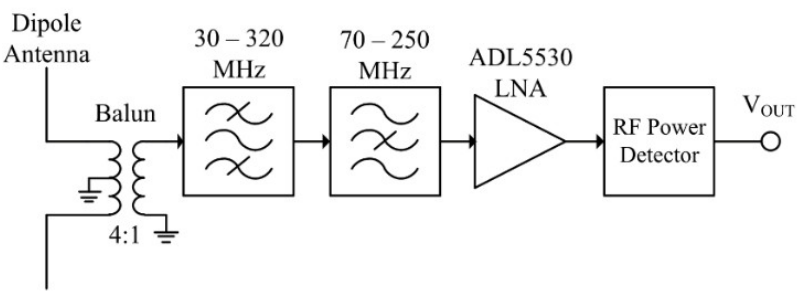
Figure 12. Block diagram of RF front-end.